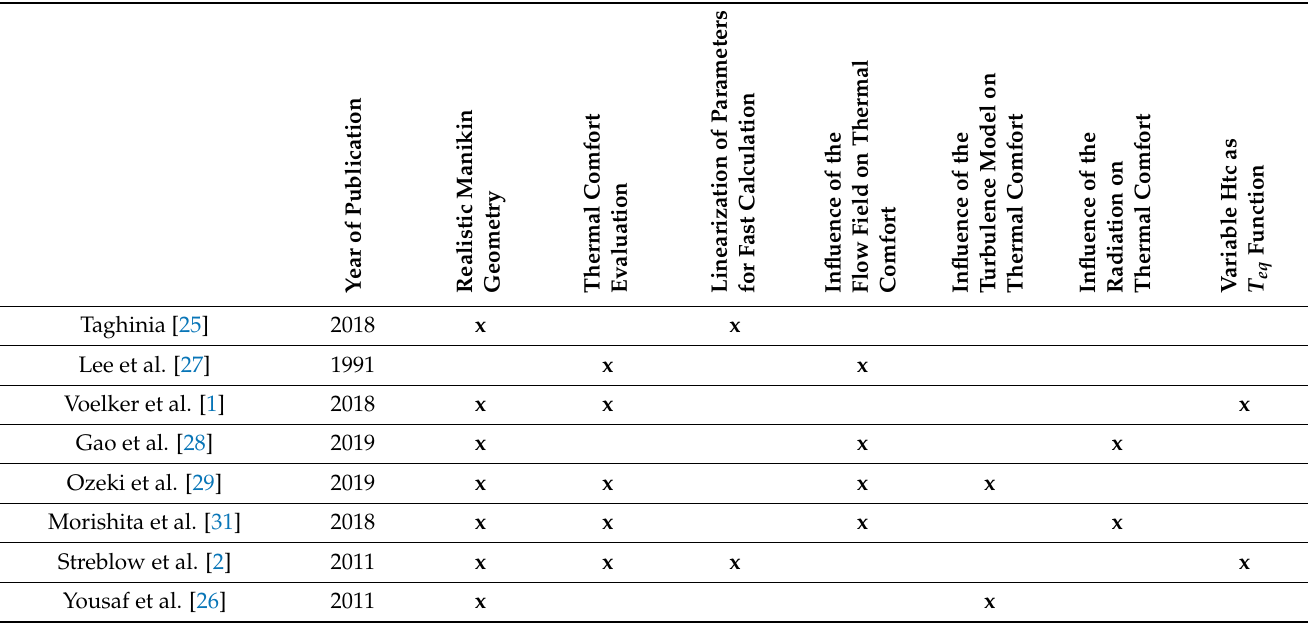
Table 1. Literature